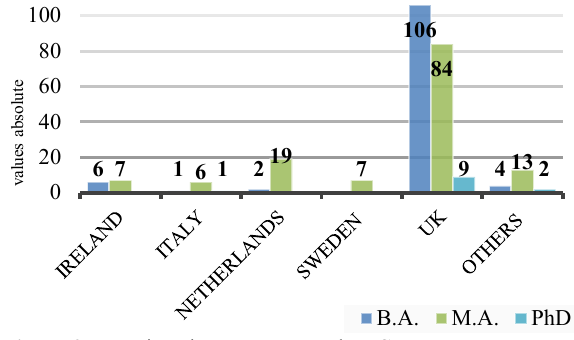
Figure 2. Locations in Europe to study DCH